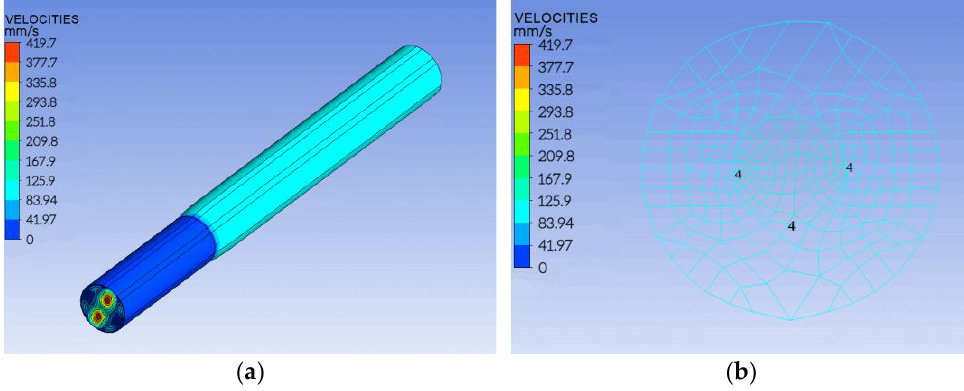
Figure 4. Three-component melt velocity distribution in the spinneret hole. ( a ) Overall cloud map; ( b ) outlet cloud map.